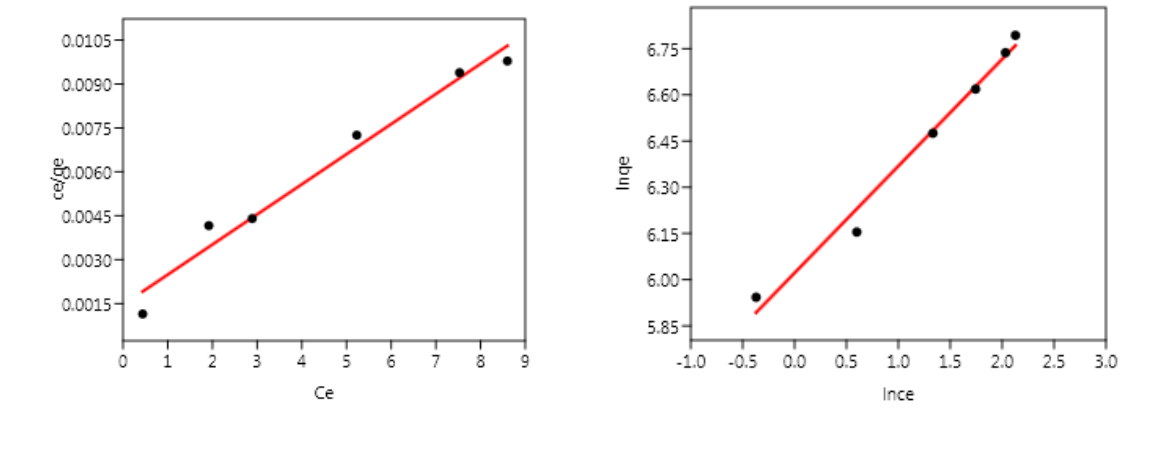
Figure 6. Langmuir adsorption isotherm for ammonia with chitosan-activated carbon nanocomposite